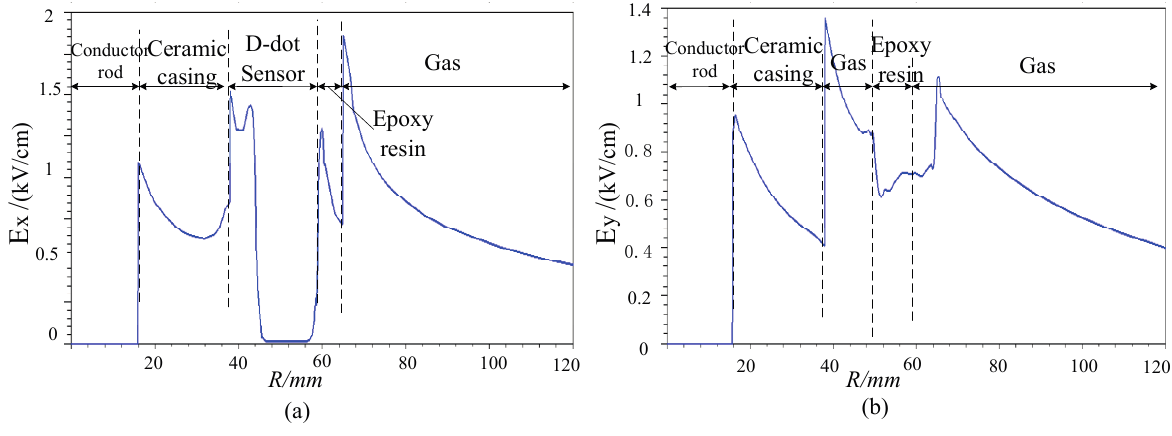
Figure 6. Distribution of electric field strength ( a ) X-orientation; ( b ) Y-orientation.